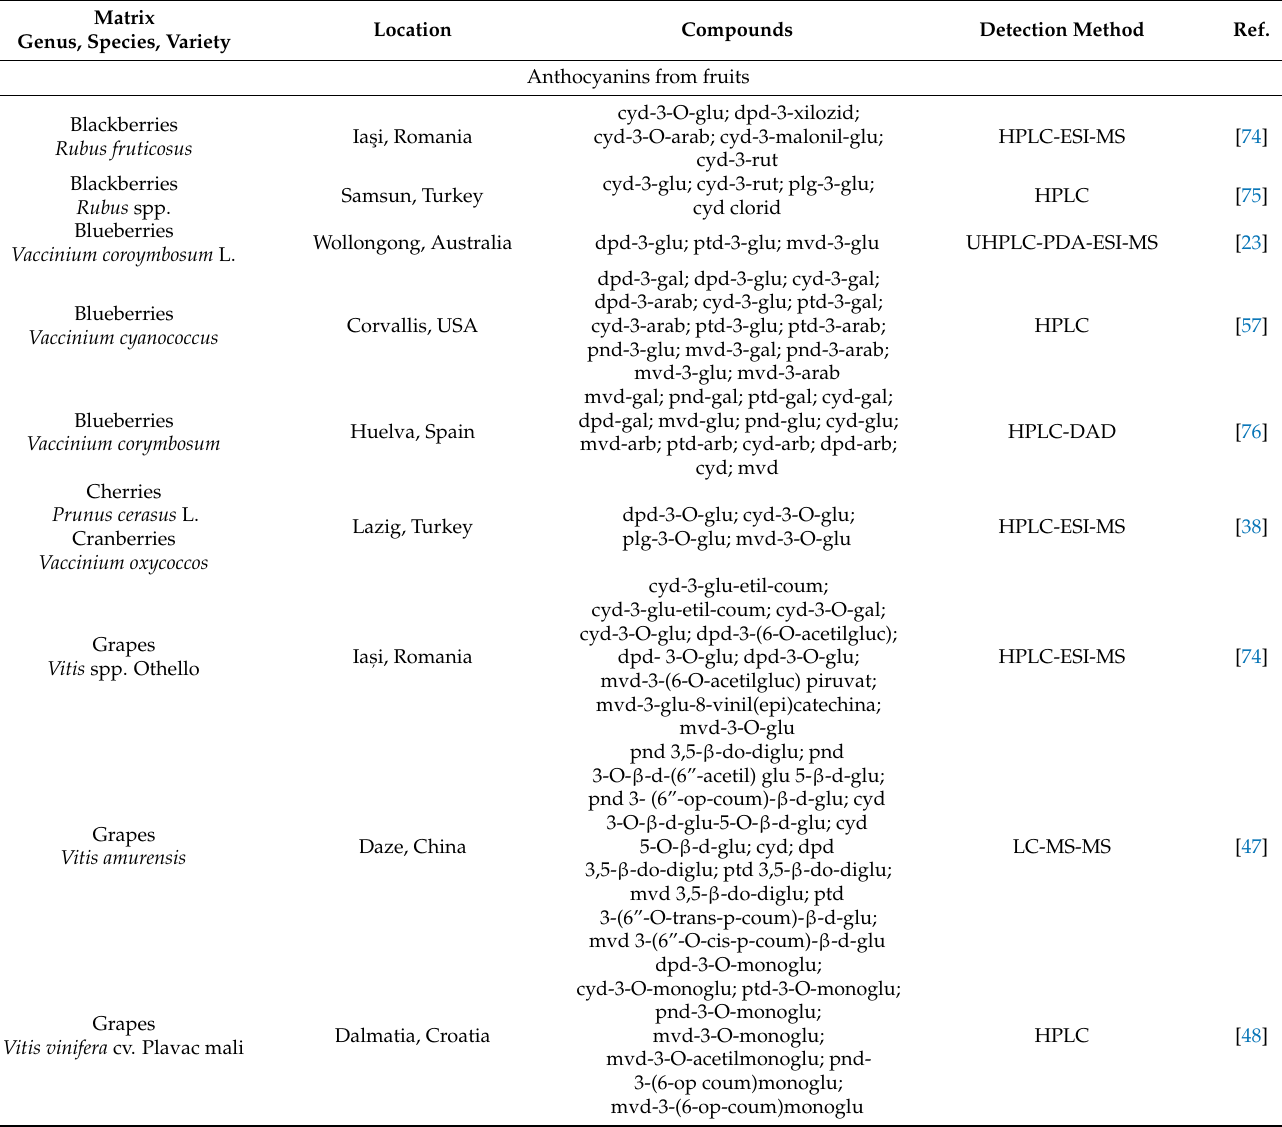
Table 3. Anthocyanin compounds identified in different food